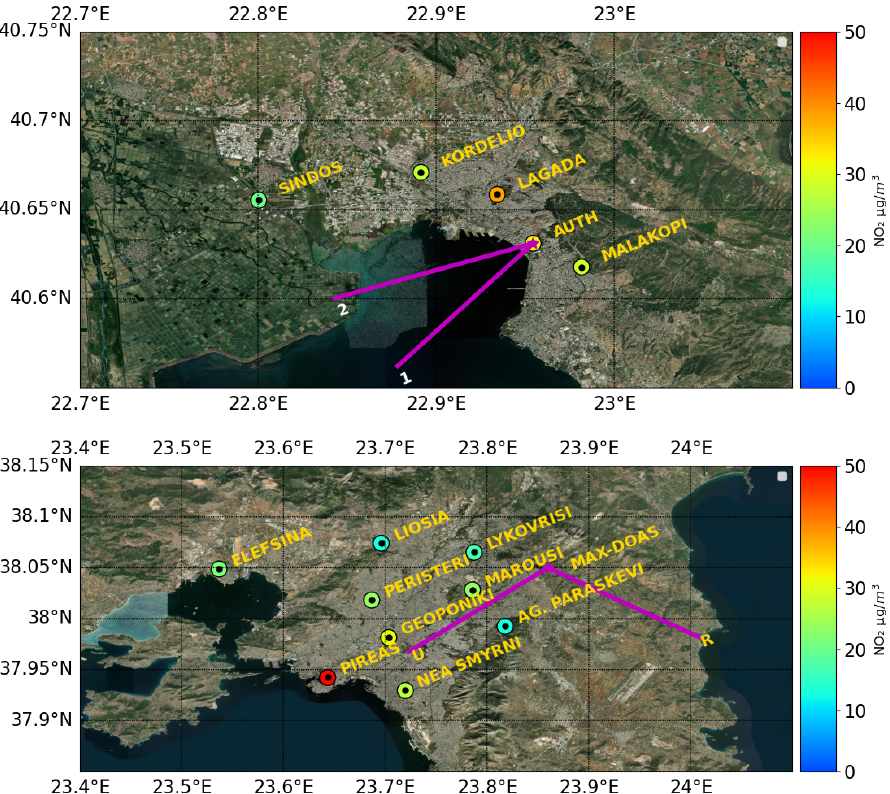
Figure 2. In situ air quality measurements in the region of Thessaloniki (top) and the region of Attica (bottom). The points represent the stations, while the colour bar denotes the average NO 2 measurements over June–December 2018. The purple lines represent the direction of the MAX-DOAS measurements in the area (created using background from ArcGIS